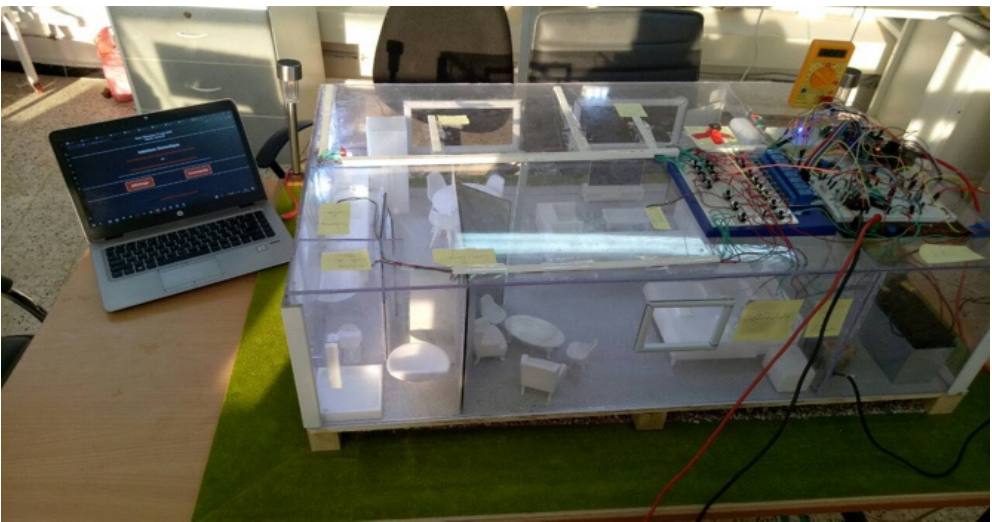
Figure 10. Implementation of the system in the prototype of the solar house on a small scale.